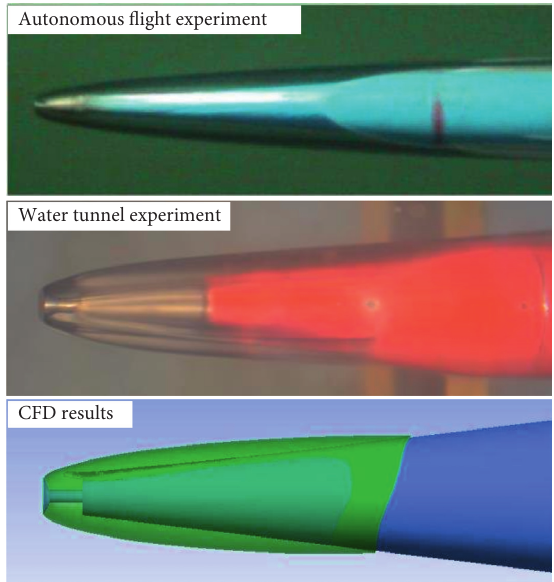
Figure 7: Partial cavitation (closes at conical section).